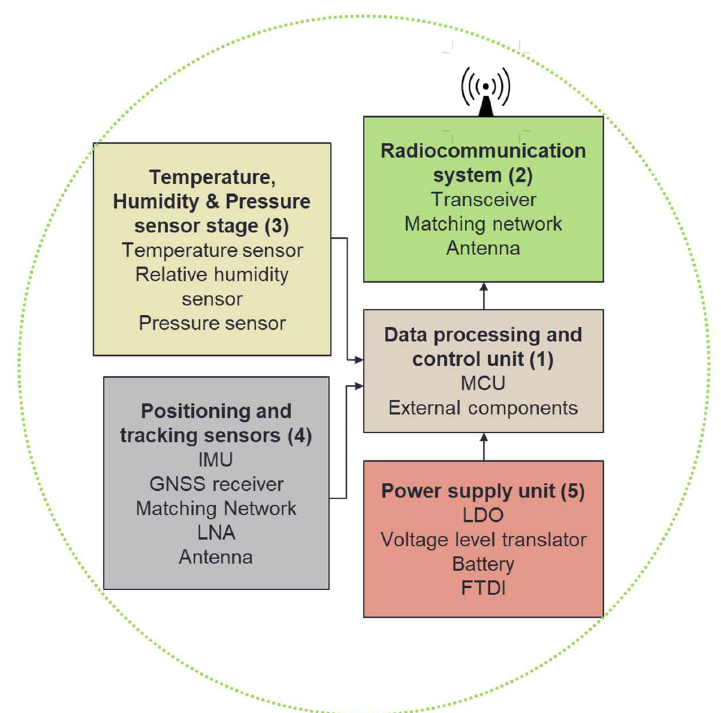
Figure 2. Block diagram of the mini radioprobe.